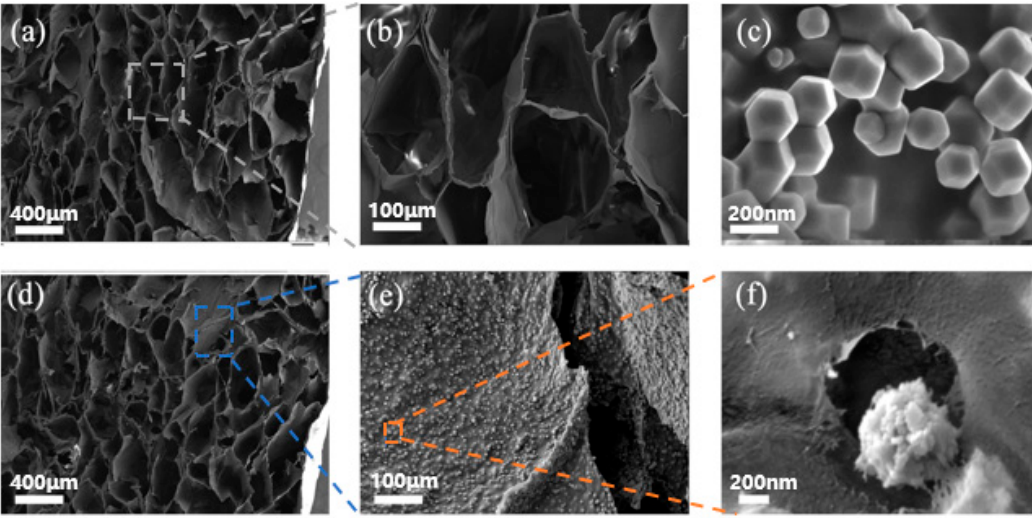
Figure 2. Scanning electron microscopy (SEM) image of ( a ) and( b ) GEL; ( c ) ZIF-67; ( d ‒ f ) Co-ZIF@GEL.